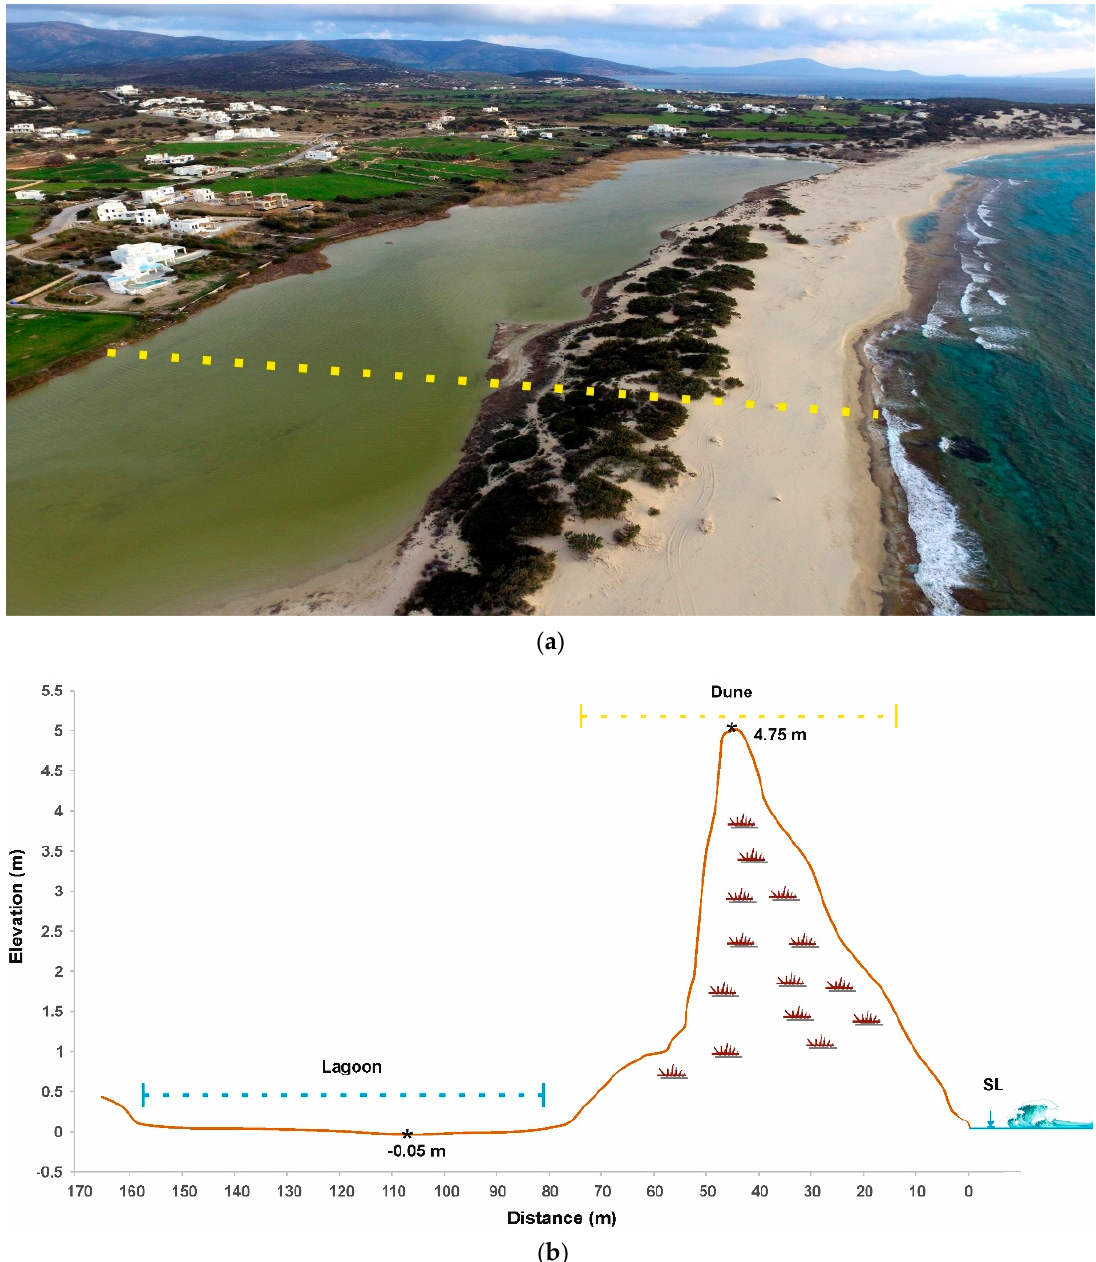
Figure 8. ( a ) Aerial photograph of Glyfada site, with the location of the section; ( b ) Sketch of the cross section.